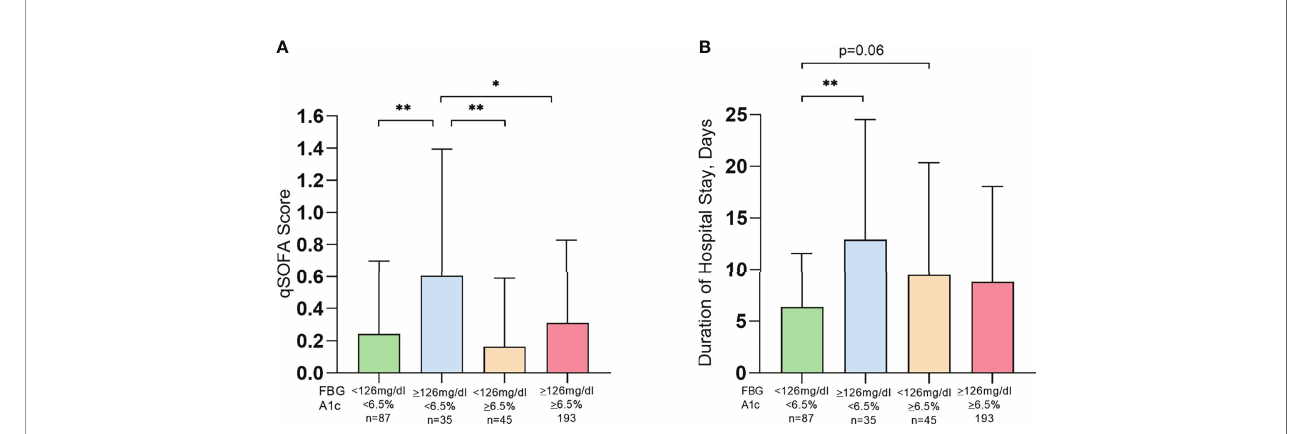
FIGURE 3 | Patients with acute glycemia represented higher severity (A) and length of hospital stay (B) among hospitalized COVID-19 patients. FBG, fasting blood glucose; HbA1c, glycated hemoglobin; qSOFA, quick sepsis-related organ failure assessment; Data presented as mean ± SD. *p<0.05,